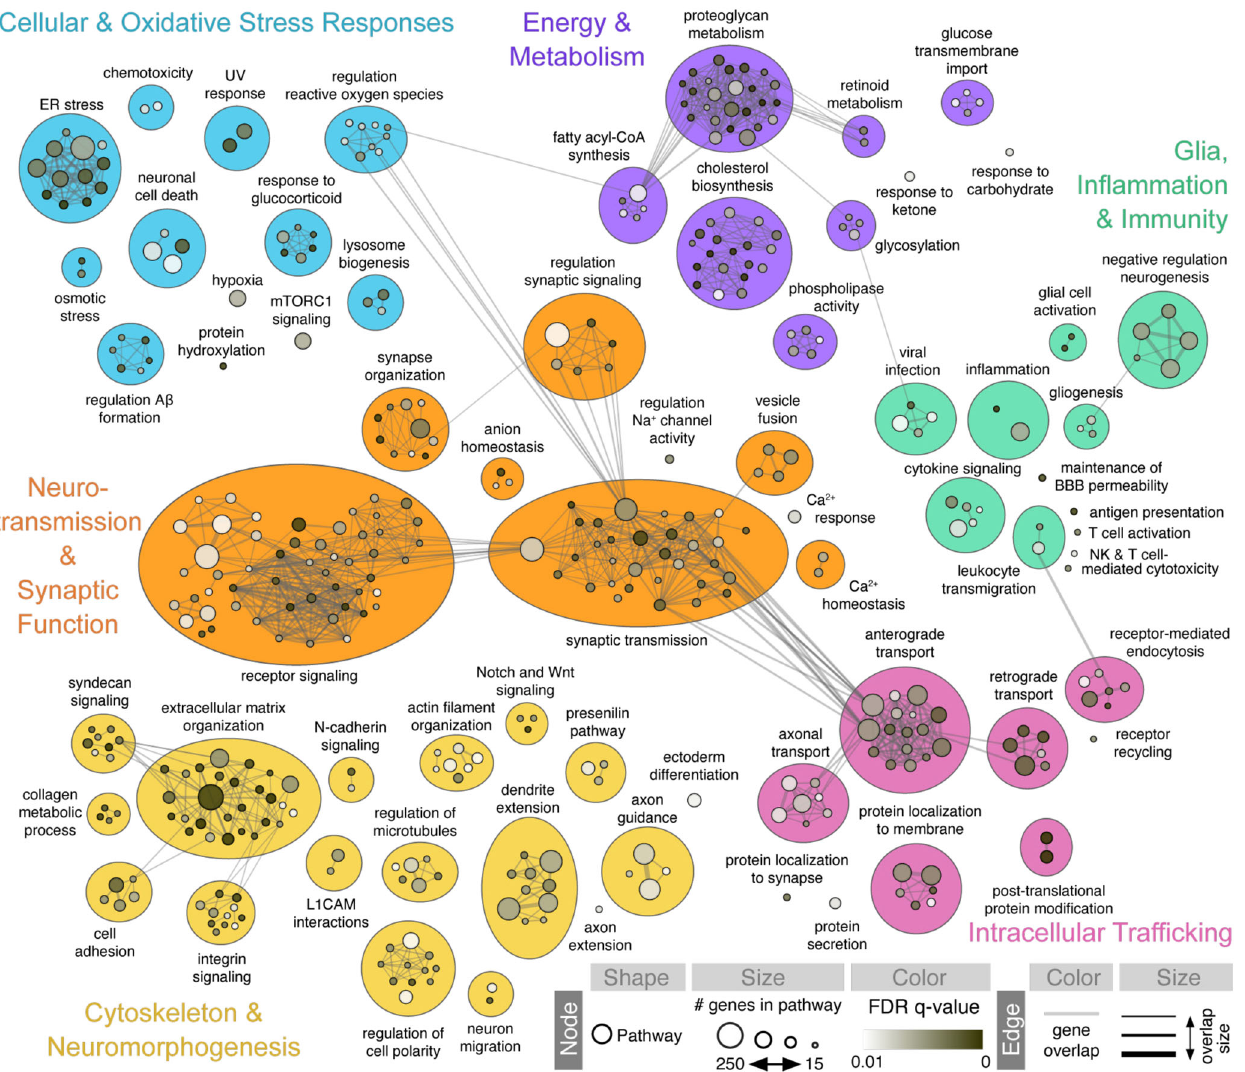
Fig. 4 Gene Set Enrichment Analysis identi fi es transcriptomic pathways perturbed in Parkinson ’ s patient-derived neurons. Enrichment map representation of the main biological processes dysregulated in PD versus control reprogrammed neurons. Pathway gene sets ( n = 5654 passing size fi lters) corresponding to gene ontology (GO) biological process terms were tested for enrichment by Gene Set Enrichment Analysis (GSEA) 133 following a recent protocol 83 . GSEA revealed signi fi cant (FDR- q < 0.01) overrepresentation of 579 pathway gene sets at the top of the list of expressed genes ( n = 24,693) rank-ordered by decreasing overall dysregulation score ( D overall , genes with highest dysregulation across all studies at top). Functionally related pathway sets were assigned a label and grouped together based on similarity, resulting in 408 dysregulated pathways related to six main biological themes, including (i) neurotransmission and synaptic function, (ii) cytoskeleton and neuromorphogenesis, (iii) cellular and oxidative stress responses, (iv) energy and metabolism, (v) glia, in fl ammation and immunity, and (vi) intracellular traf fi cking. Node size is proportional to the number of genes in the pathway gene set, and node color intensity indicates the statistical signi fi cance of GO term enrichment. Edge thickness represents the degree of gene overlap between connected biological pathways. Detailed pathway enrichment results are provided in Supplementary Table drug candidates based on the PD transcriptional signature from the reprogrammed neurons, we performed a GSEA of the ranked list of dysregulated genes against DrugBank ’ s database of 5,724 drug-target gene associations 90 . Our analysis revealed signi fi cant enrichment for 18 therapeutic drug candidates, most of which have established or predicted roles in the regulation of neurotransmission and cellular/oxidative stress responses (Fig. 6A). Two enriched candidates (i.e., glutamate and aspartate) directly function as neurotransmitters. Several other candidates (i.e., calcium phosphate dihydrate, calcium citrate, calcium